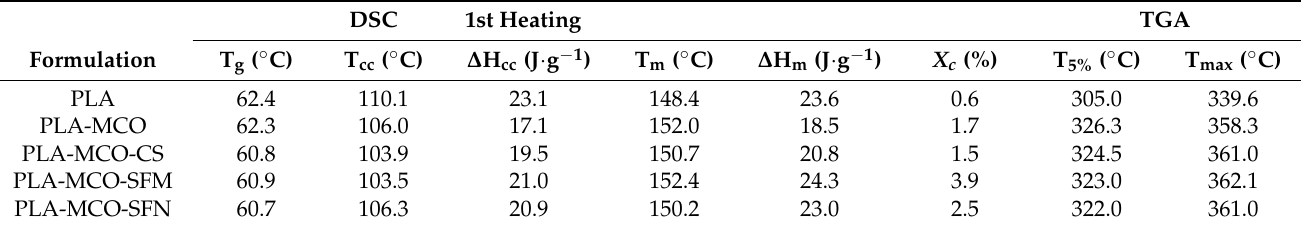
Table 3. Summary of the DSC and TGA thermal parameters of neat PLA, plasticized PLA, and PLA-MCO-Silk composites.